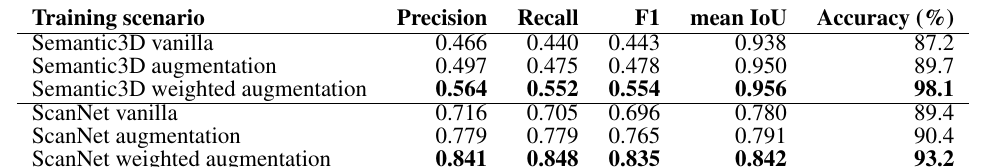
Table 1. Semantic3D and ScanNet validation dataset performance results. In all scenarios augmentation performed better than when no augmentation was used. Weighted augmentation further increases performance.